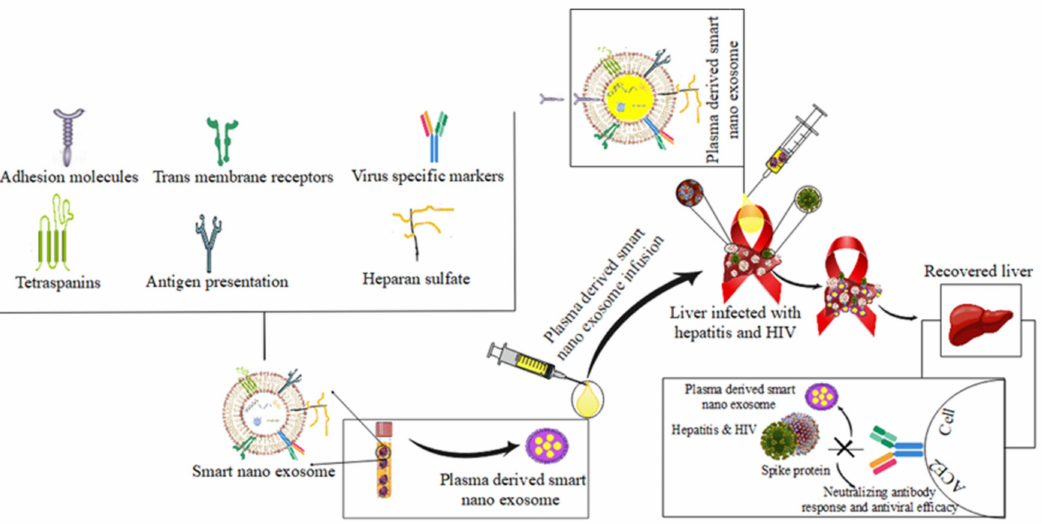
Figure 6. The mechanism of treatment of hepatitis and HIV by plasma-derived smart